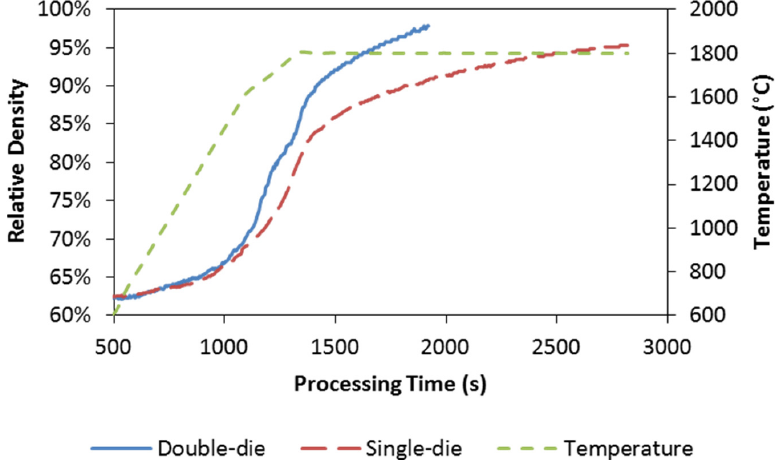
Figure 4. Relative density evolution with respect to processing time: double-die and single-die SPS at the maximum processing temperature of 1800 °C. Temperature evolution is included as secondary vertical axis.